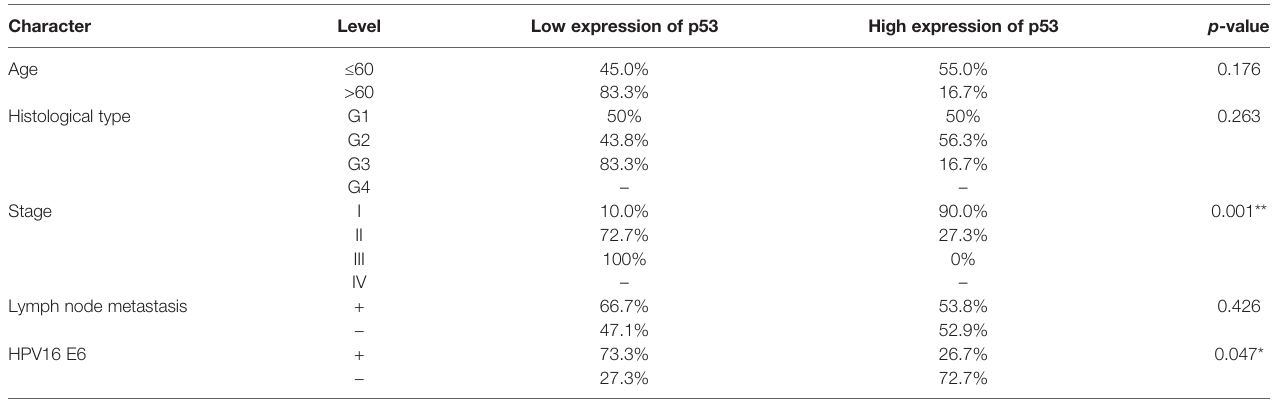
TABLE 2 | Association between p53 protein expression and clinicopathological features in cervical cancer